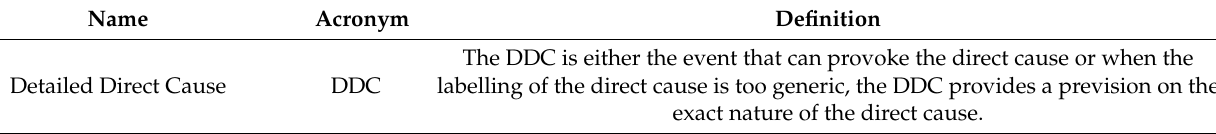
Table 2. Definition of bow-tie elements and event levels